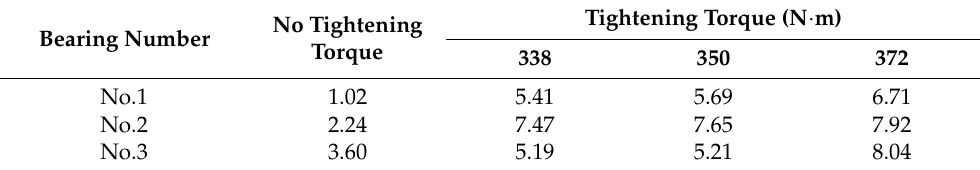
When large interference was used to install the inner ring, the inner ring deformation and cylindricity increase was induced by the large tightening axial force (375 N · m) that was used, which was 3 N · m larger than the maximum tightening torque of the bearing Table 6. The cylindricity of the bearing inner raceway under different tightening torque ( μ m) . requirement, and the test of the simulating bearing operation was carried out by bearing contact fatigue test equipment. Before the bearing was installed on the test equipment, cylindricity of the inner ring raceway is 2.90 um, and the cylindricity profile is shown in Figure 19a. After the bearing was installed on the test equipment, the cylindricity of the inner ring raceway increased to 10.98 um, and the cylindricity profile is shown in Figure 19b. The tightening axial force caused obvious the taper deformation of the inner ring raceway. Additionally, the diameters corresponding to the bearing side with laser marking of the inner ring raceway increased obviously at some positions.